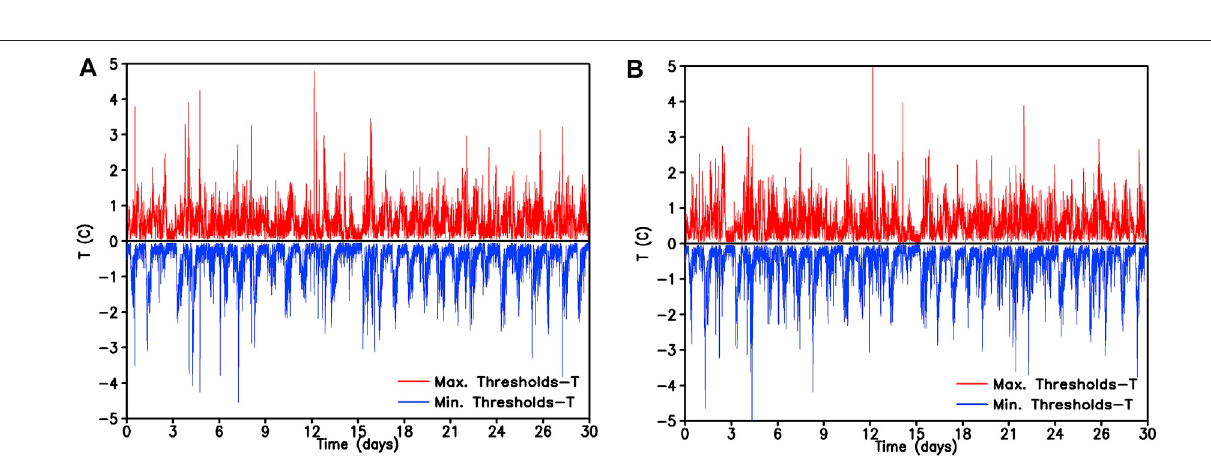
Frontiers in Earth Science |